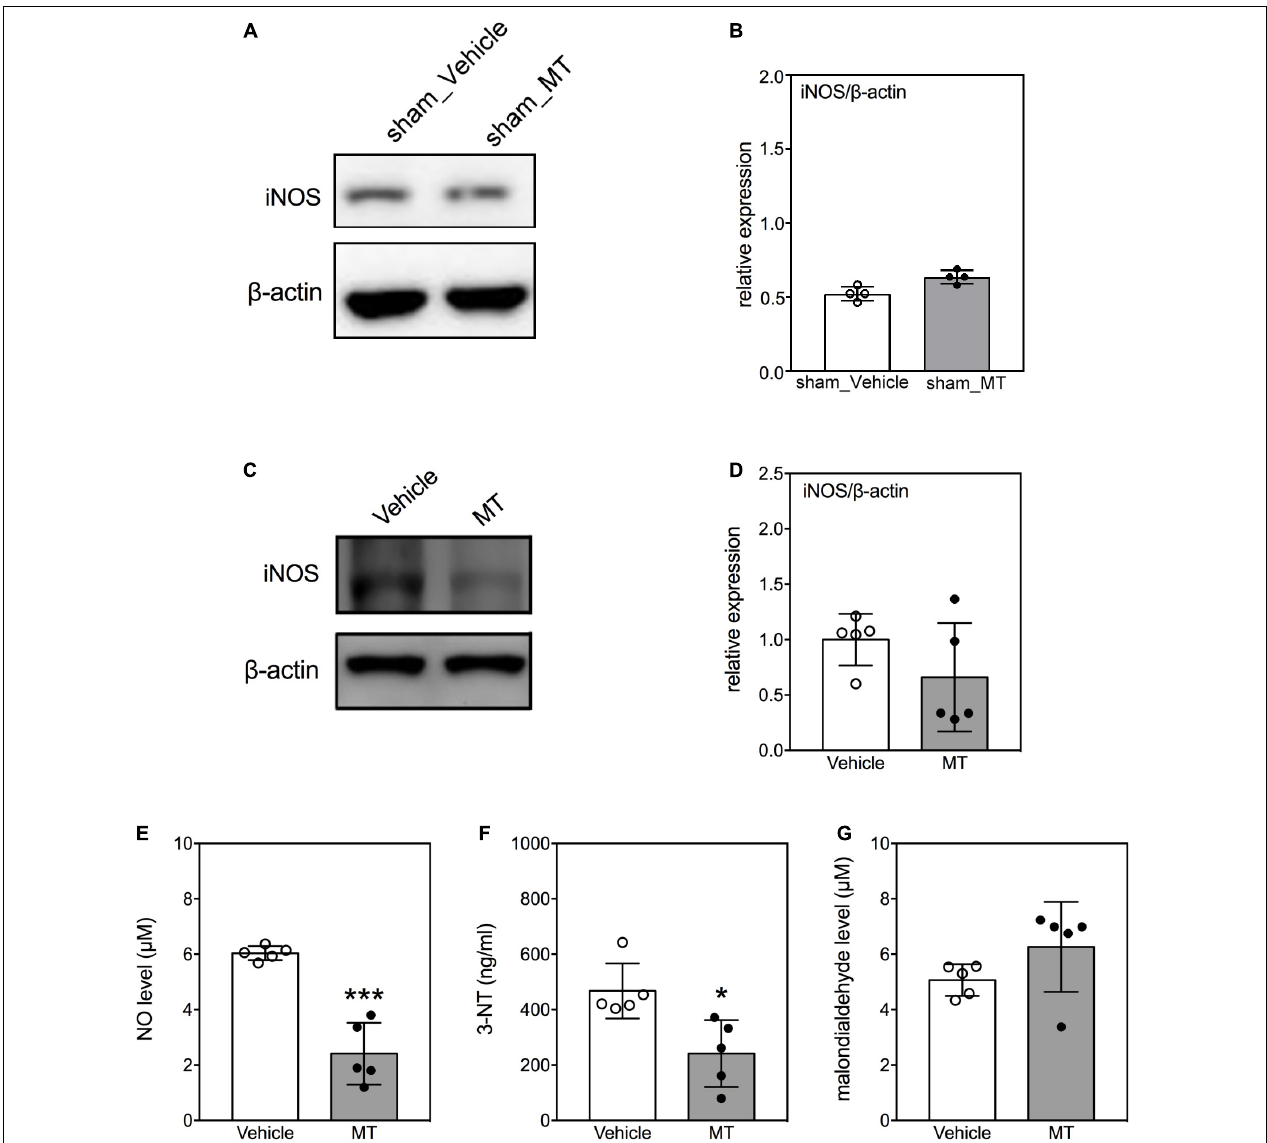
FIGURE 6 | Effects of mitochondrial transplantation on oxidative stress in the injured spinal cord of rats with traumatic SCI on PID 1. (A) Representative micrograph of Western blot of iNOS in sham control groups. (B) Quantitative results of relative expression of iNOS in sham control groups. (C) Representative micrograph of Western blot of iNOS in SCI groups on PID 1. (D) Quantitative results of relative expression of iNOS in SCI groups on PID 1. The 1-cm spinal cord specimens centered at the epicenter of the injured site were used in Western blots. (E–G) Quantitative results of the level of NO, 3-NT and malondialdehyde in SCI groups. Data were expressed as mean ± standard deviation. * p < 0.05, *** p < 0.001, two-tailed Student’s t -test. N = 4–5. MT, mitochondria